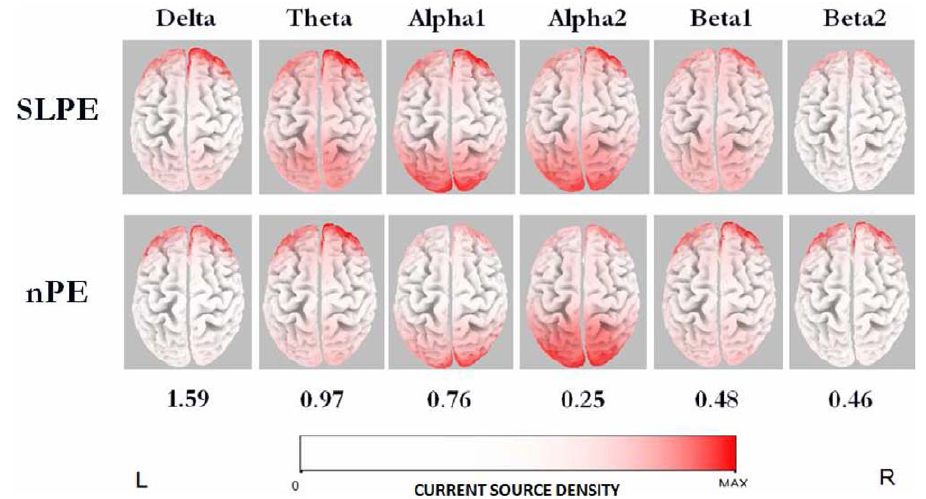
Figure 1. Averaged eLORETA solutions (current density at cortical voxels) of EEG sources for each frequency band. The maximum current density values for each frequency are given below the corresponding column. SLPE, schizophrenia-like psychosis of epilepsy; nPE, nonpsychotic epilepsy; L, left; R, right. cortex (i.e., posterior cingulate/precuneus cortex) (SLPE: